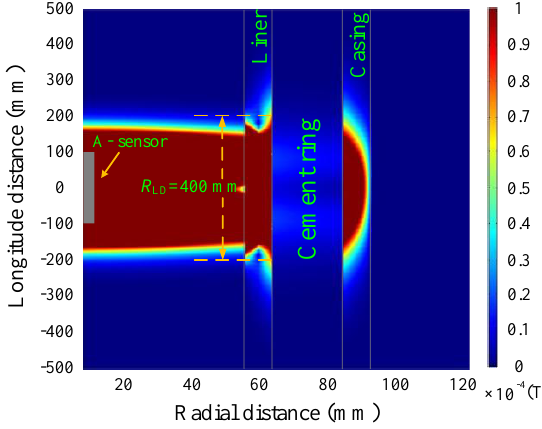
Figure 9. Eddy-current field of the auxiliary sensor at 30 ms.